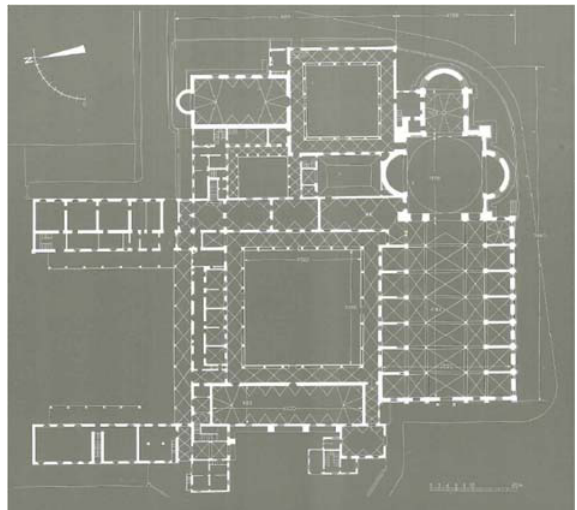
Figure 2. 1937 Survey by A.Pica from Santa Maria delle Grazie in Milano, Milano, 1983.